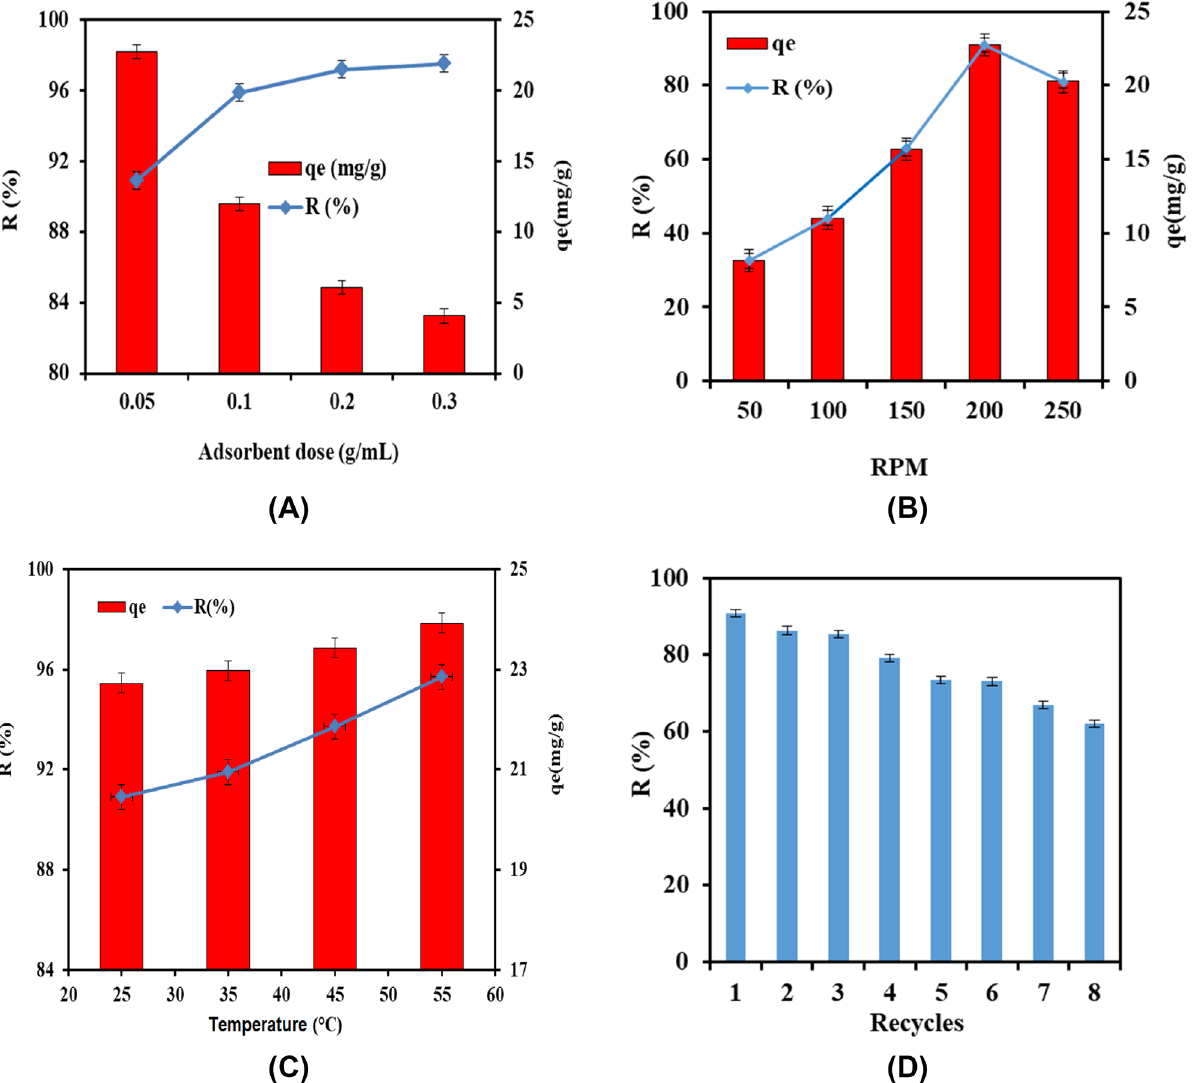
Figure 7. Impacts of ( A ) adsorbent dose, ( B ) agitation speed and ( C ) adsorption medium temperature and ( D ) Reusability of K@AM-CTS composite beads